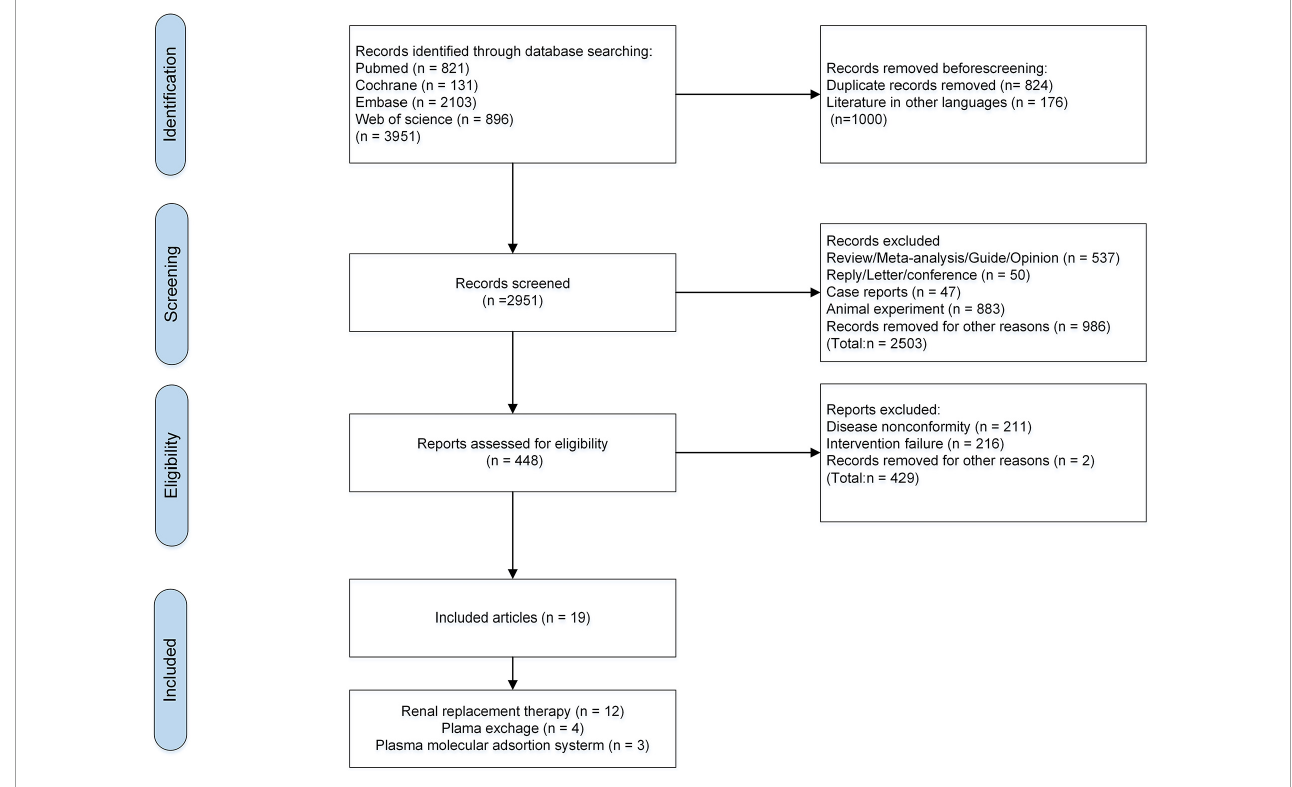
FIGURE1 Flow diagram of search results according to